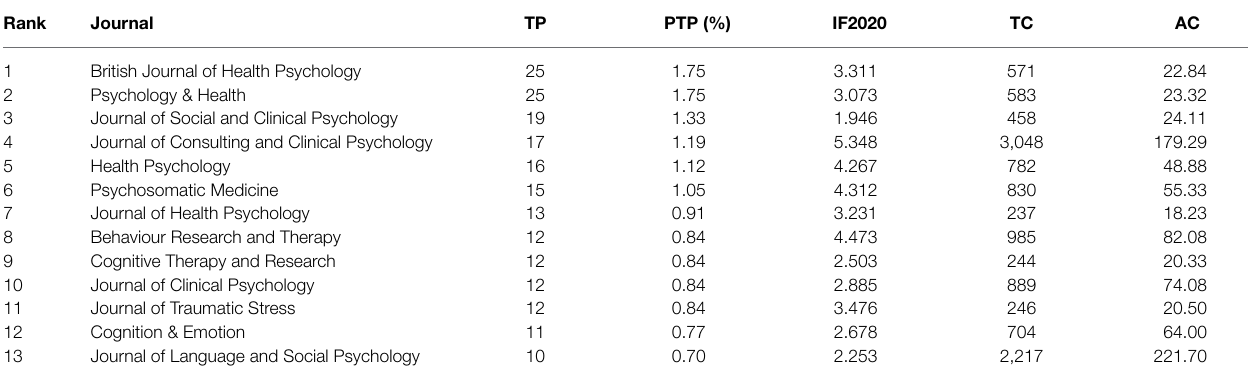
TABLE 5 | The top 13 most published journals in expressive writing studies.